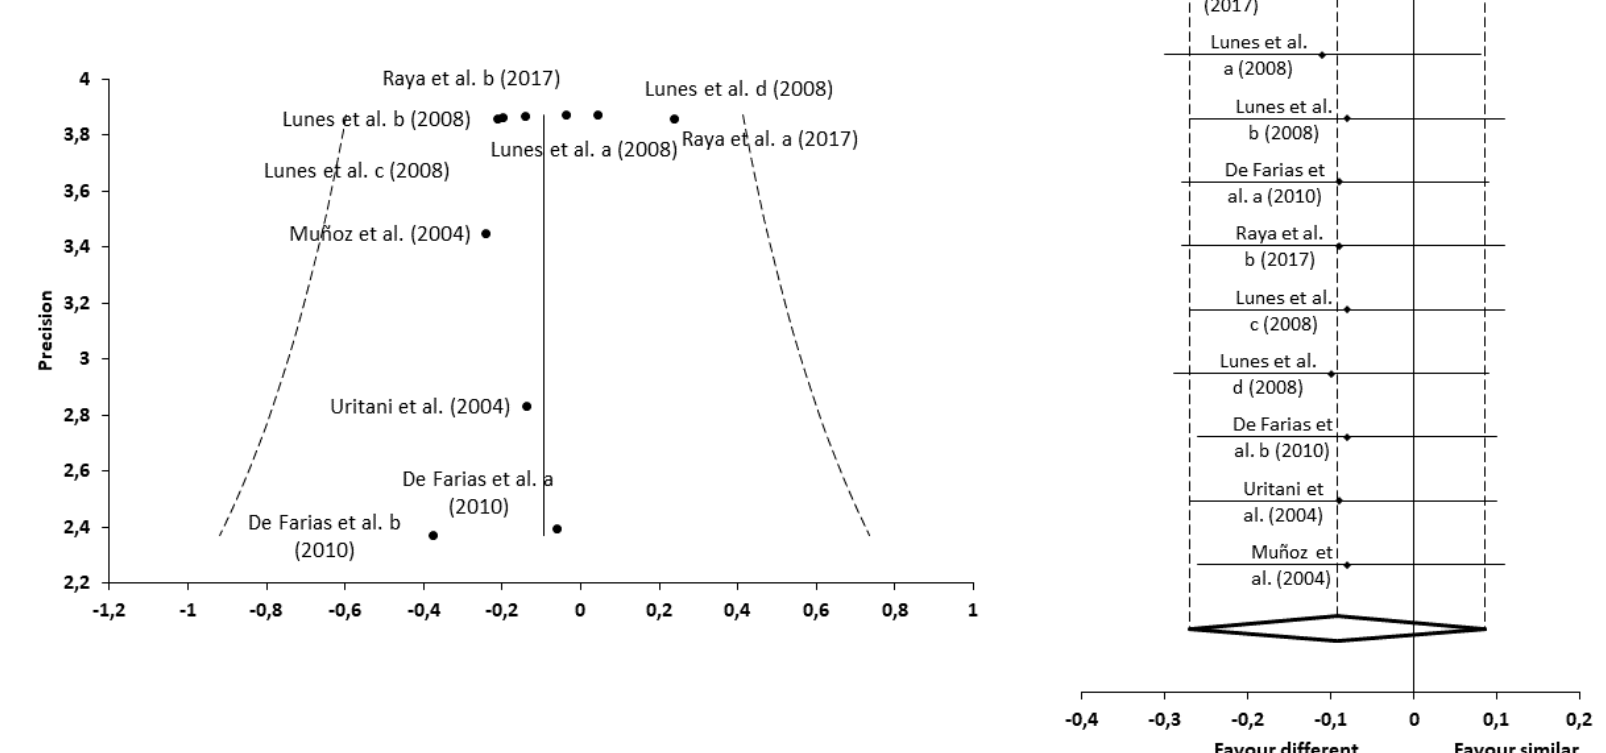
Figure A2. Publication bias heterogeneity funnel plot for the craniocervical position. A funnel plot was used to assess the risk of publication bias. The diagonal lines represent 95% confidence limits.